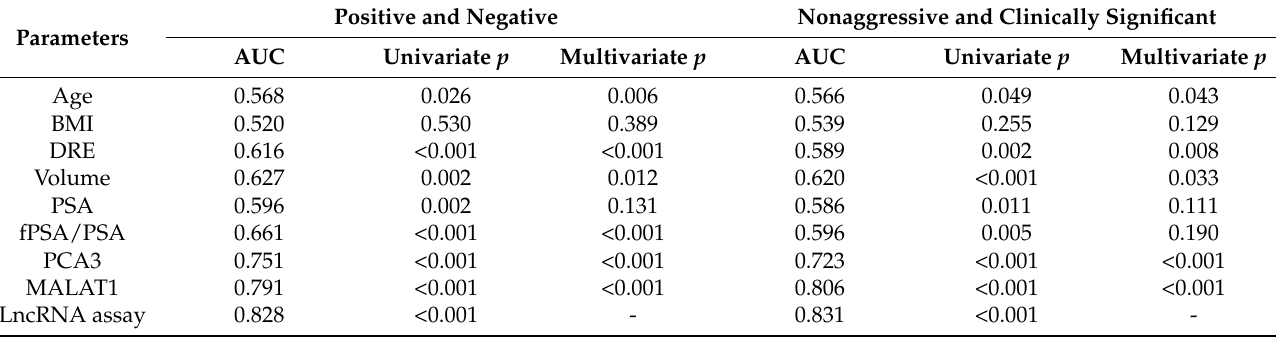
Table 2. Performance of the lncRNA assay and PCa-associated clinical features to predict biopsy results in the discovery